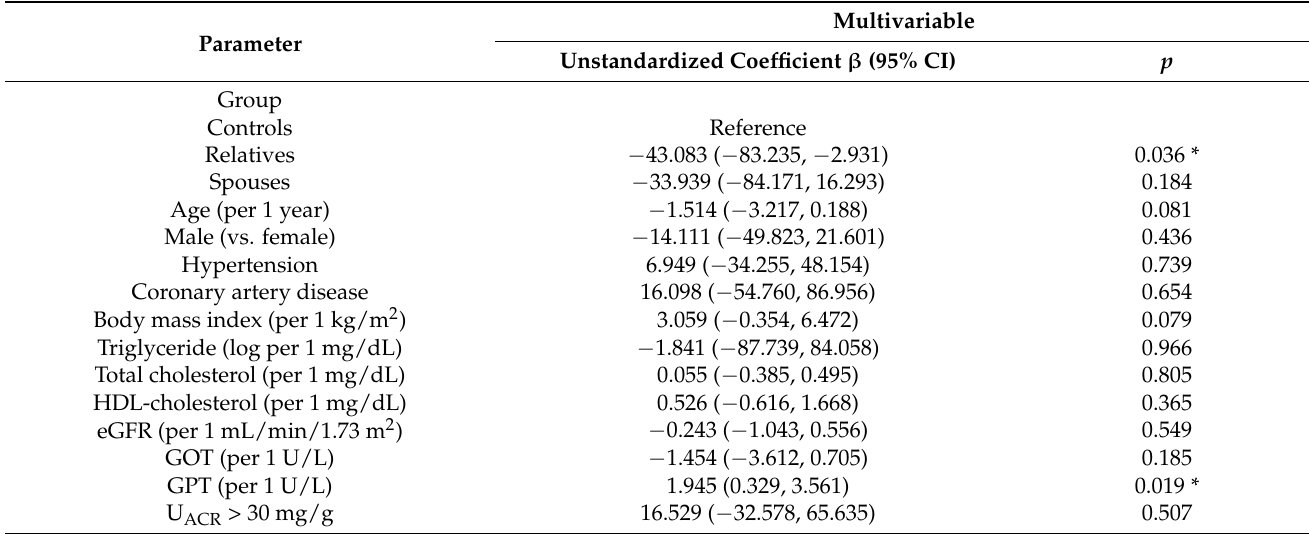
Table 4. Determinants of β -cell function using multivariable linear regression analysis.